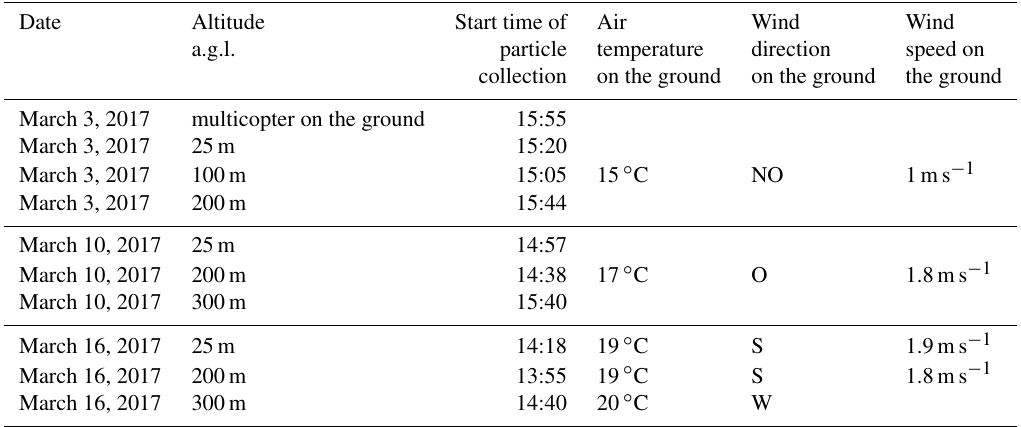
Table 1. Aerosol particle collection flights carried out on 3, 10, and 16 March 2017 performed at different hovering altitudes. Date Altitude Start time of Air Wind Wind a.g.l. particle temperature direction speed on collection on the ground on the ground the ground March 3, 2017 multicopter on the ground 15:55